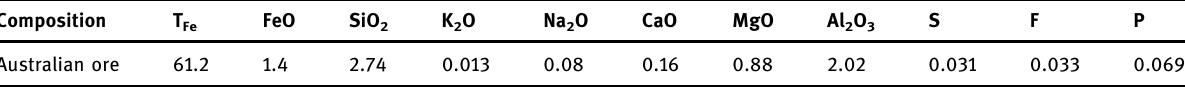
Table 1: Chemical composition of Australian ore ( wt% )